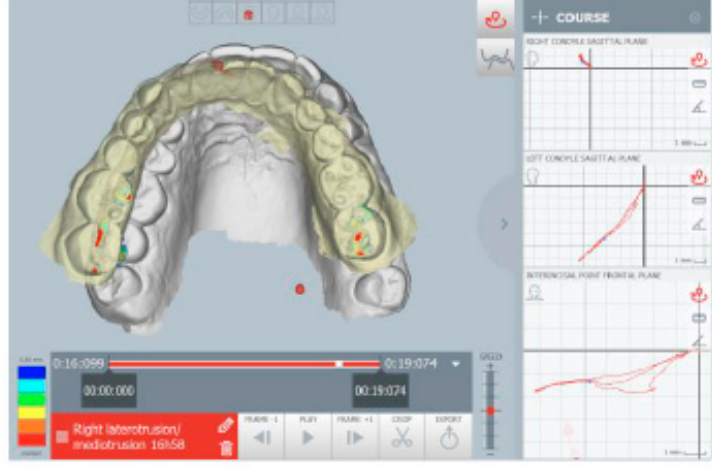
Figure 5. Right lateral movement.